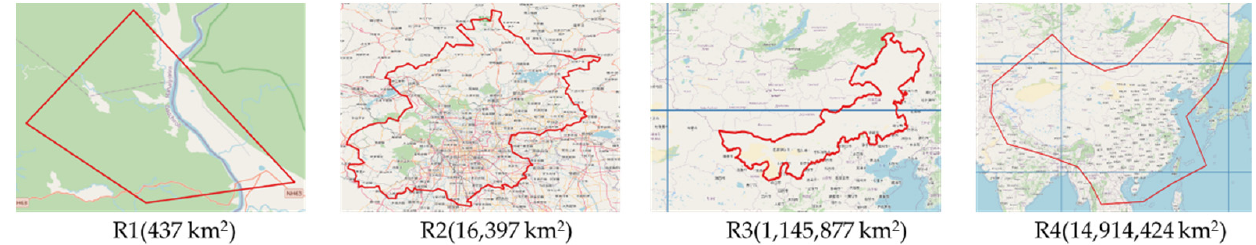
Figure 24. Query regions with different sizes.